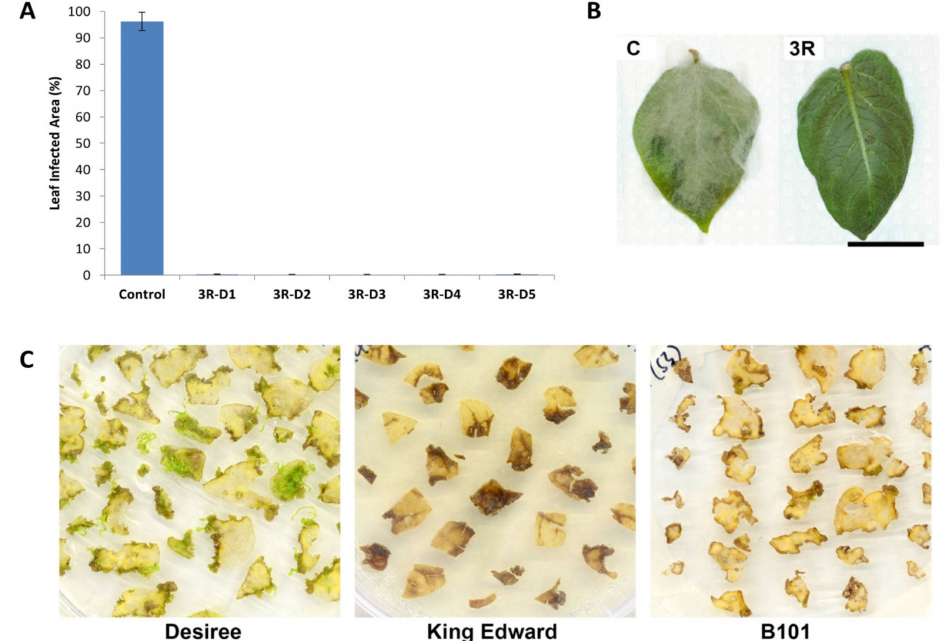
Figure 1. Solanum tuberosum cv. D é sir é e transformed with the triple resistance (3R) gene stack RB, Rpi-blb2 and Rpi-vnt1.1 against P. infestans and shoot regeneration. ( A ) Mean leaf a ff ected area for detached-leaf assay for wild-type D é sir é e (Control) and 3R D é sir é e (3R-D1, 3R-D2, 3R-D3, 3R-D4, and 3R-D5) against P. infestans at 7 dpi. Results are expressed as mean % leaf area ± standard deviation. Ten leaves were observed for each line and the detached leaf assay was repeated three times. All